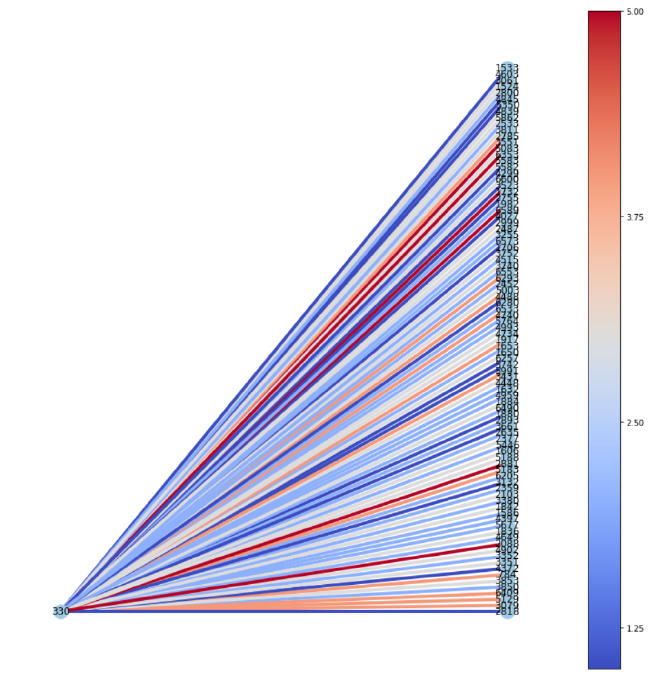
Figure 8. A visualized subgraph when the predicted score is